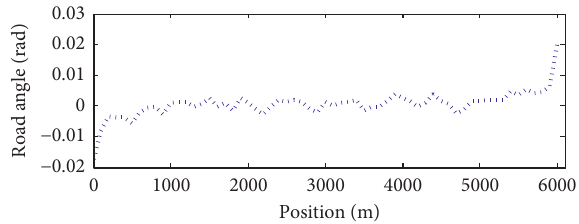
Figure 4: Slope information of road